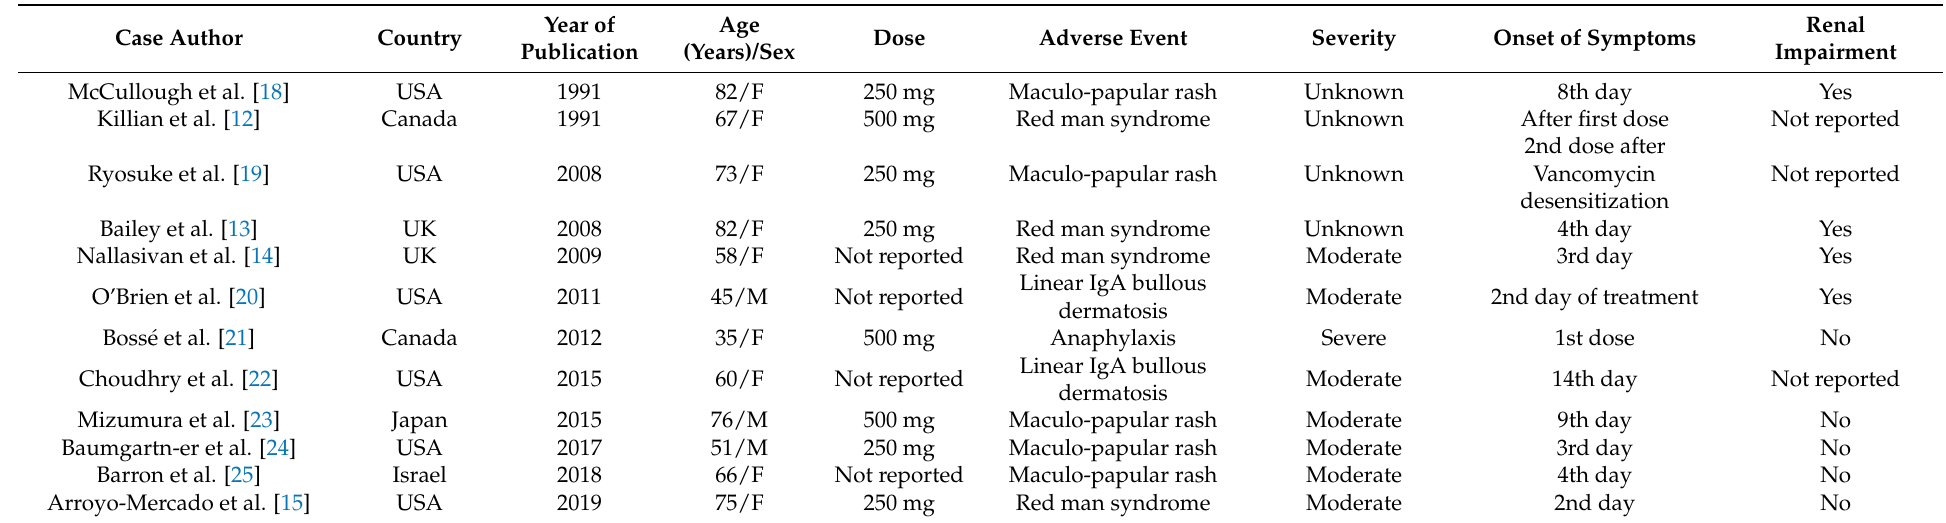
Table 2. Summary of the characteristics of published cases of oral Vancomycin allergic